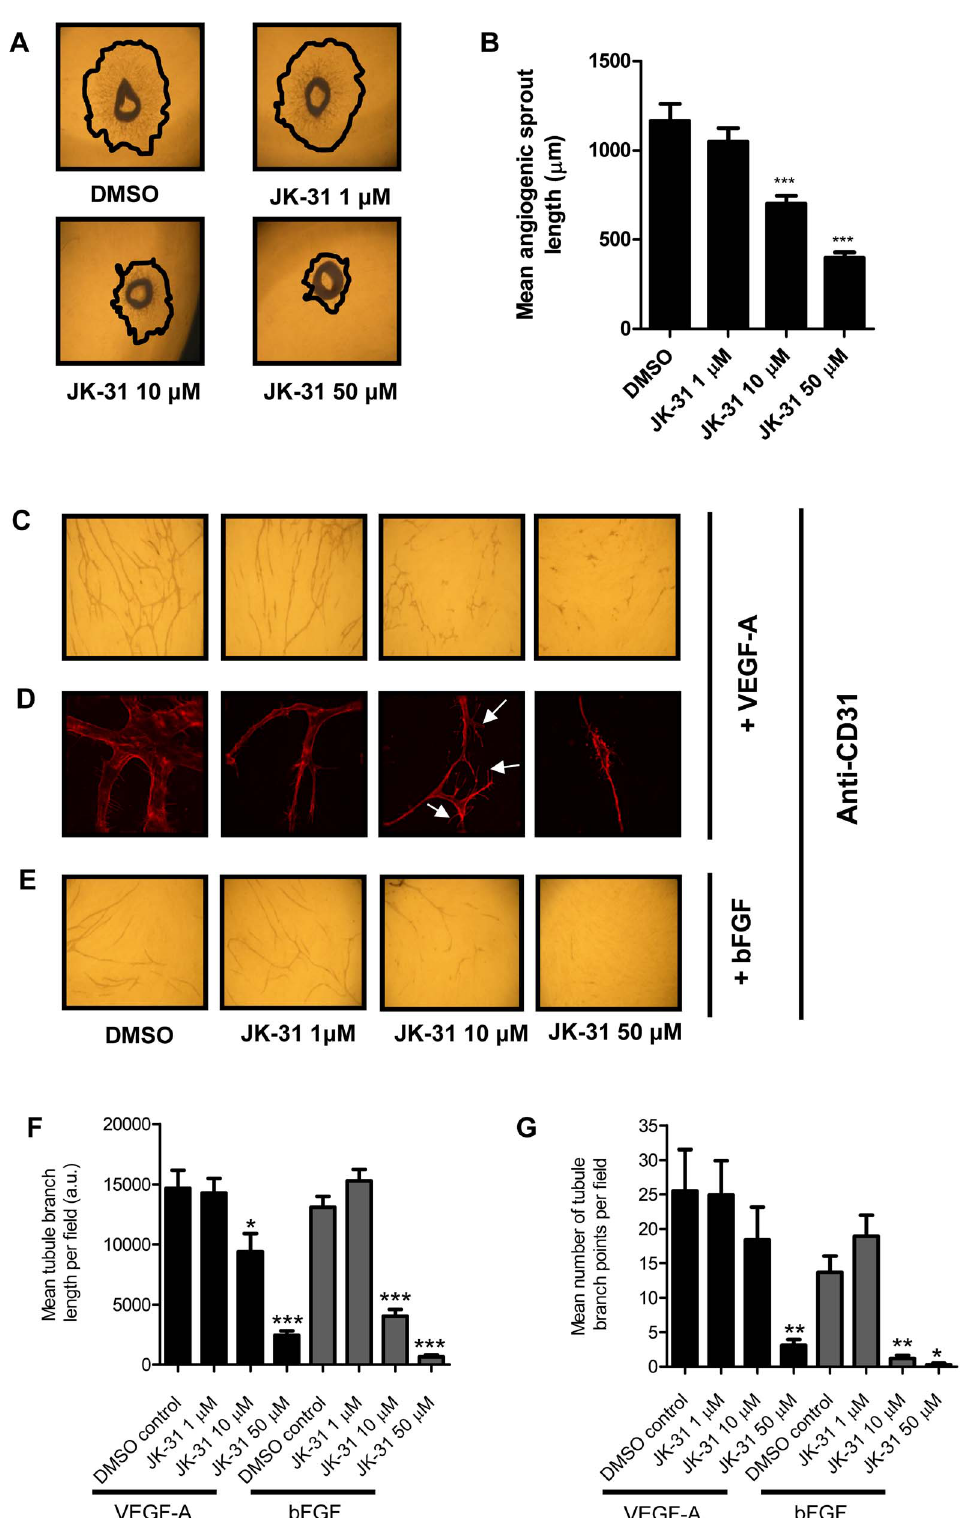
Figure 3. JK-31 inhibits angiogenesis in an exvivo murine model and invitro . (A) Effects of JK-31 on ex vivo angiogenic sprouting from wild- type mouse aortic ring explants. Aortic rings were seeded onto Matrigel and treated with JK-31 (0, 1, 10 or 50 m M) for six days and imaged by phase- contrast microscopy. Freehand black lines delineate the outermost extent of sprouting. (B) Absolute quantification of angiogenic sprout length. For each aortic ring, the mean of three longest sprouts was calculated. Error bars represent 6 SEM (n=18; *** p , 0.001). (C) JK-31 inhibits endothelial tube formation in vitro in response to exogenous VEGF-A. HUVECs were seeded onto a confluent layer of primary fibroblasts and treated with VEGF-A (10 ng/ml) for seven days in the presence of DMSO or JK-31 (1, 10 or 50 m M). Co-cultures were stained with CD31 antibody followed by HRP-